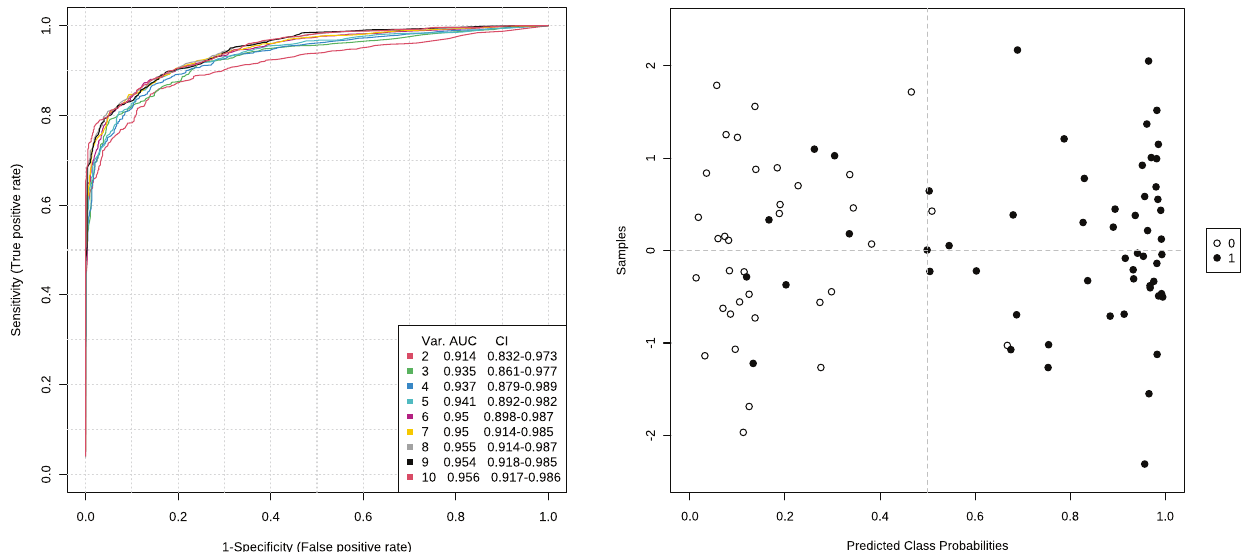
Fig. 4 ROC curve-based multivariate analysis for the variables with VIP values > 1 that were statistically signi fi cant for the distinction of head and neck paraganglioma (HNPGL) patients from healthy controls (HCs) and acoustic neuroma/cholesteatoma (AN/CH) patients. To the left, cumulative curves based on 2, 3, 4, 5, 6, 7, 8, 9 and 10 metabolites respectively, with area under the curve (AUC) and con fi dence interval (CI) values. To the right, confusion matrix after cross-validation of the cumulative ROC curve obtained with dAdo and C26:0-LPC. The HNPGL and non-HNPGLs samples, inclusive of HCs and AN/CH, are displayed as black and white dots, respectively.